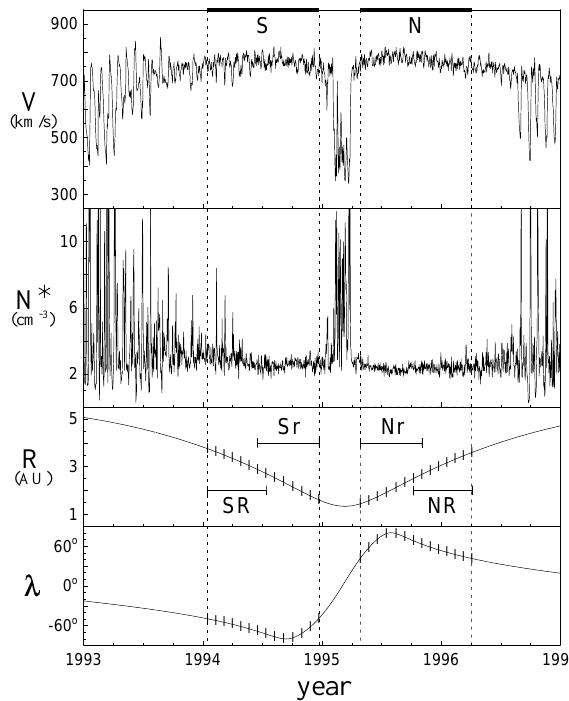
Fig. 1. From top to bottom, daily averages of the solar wind veloc- ity V , of the proton number density N ∗ (normalized to 1AU), and of the Ulysses heliocentric distance R and heliographic latitude λ are plotted versus time for years 1993 to 1996. Thick bars on top and dashed vertical lines highlight the analysed intervals during the south (S) and north (N) polar pass of the first out-of-ecliptic orbit. See text for further details.